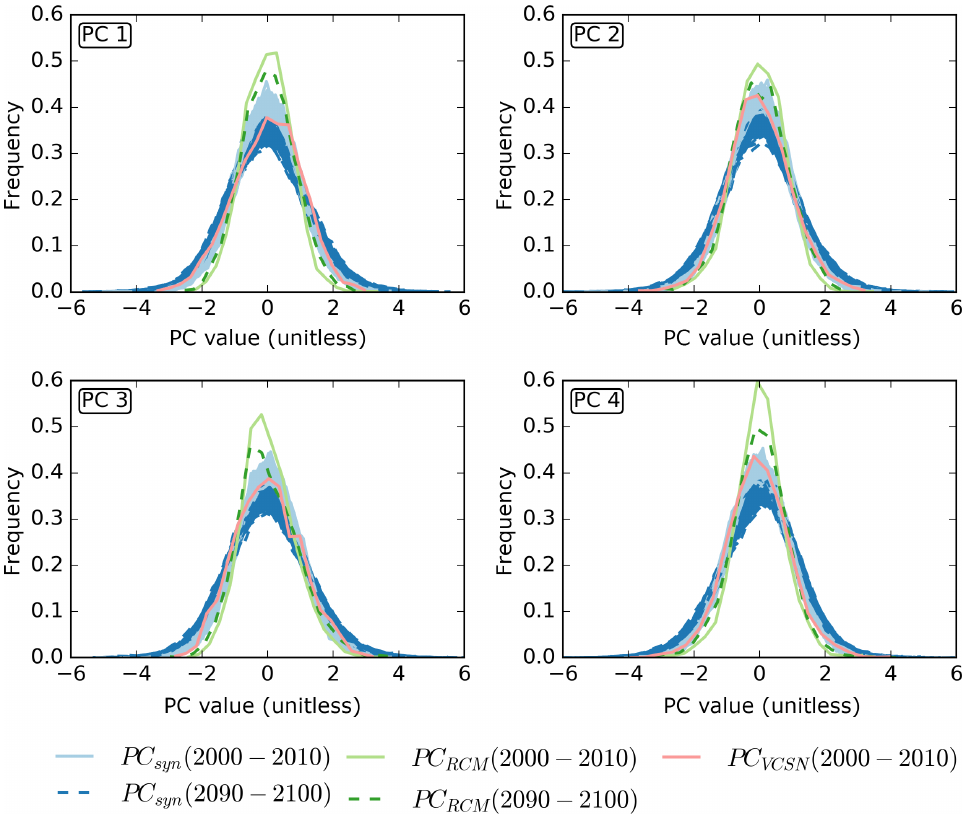
Figure 7. PDFs of the first four synthetic (PC syn ) and RCM (PC RCM ) PC time series for the first decade of the 21st century are shown as solid lines and PDFs for the last decade of the 21st century are shown as dashed lines. PC RCM and PC syn were both derived from the NorESM1-M RCM output as an example. The PDF from the PC time series (2000–2010) obtained from VCSN is also shown (PC VCSN ). The disagreement between the PC RCM and PC VCSN validates the use of VCSN weather noise as the basis for our stochastic weather generator, and the good agreement between the ensemble of PC syn and PC VCSN demonstrates that the EPIC method generates synthetic PC time series with a degree of variability that matches